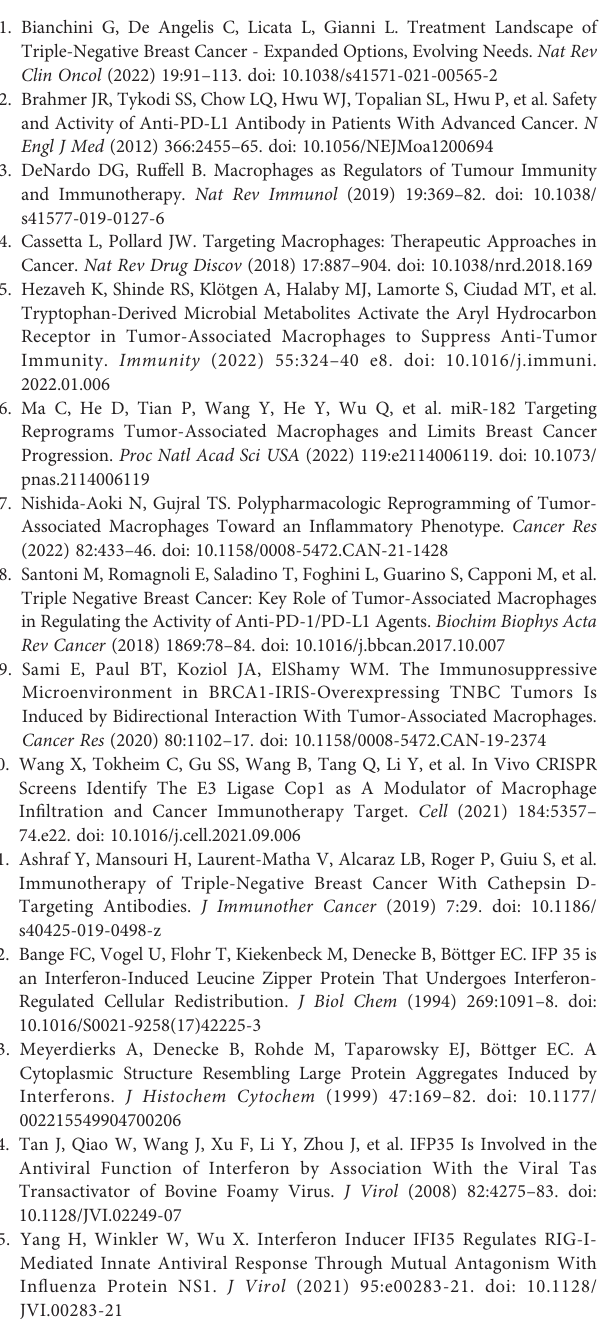
Supplementary Figure 1 | 12 cell clusters were annotated, which included multiple immunecellclusters,epithelialcells, stromalcells,endothelialcells,andtissuestemcells.